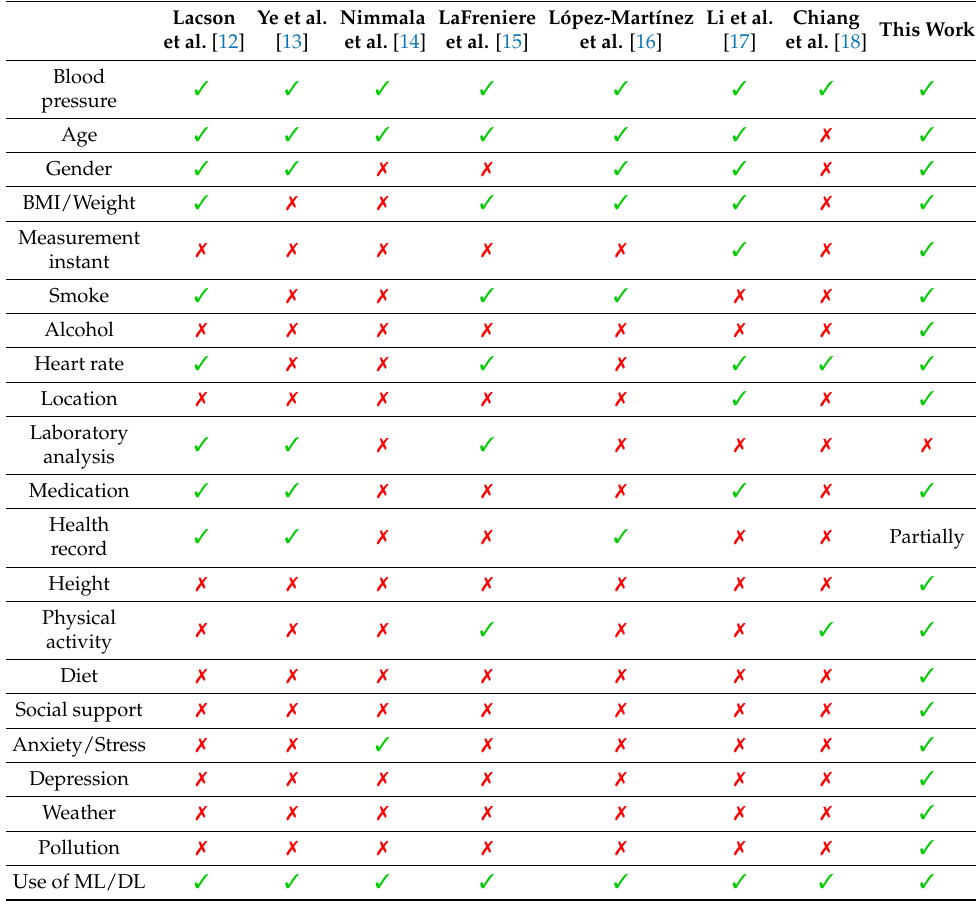
Table 1. List of features considered in the publications analyzed in the literature. A green tick ( (cid:51) ) indicates that a publication has considered a particular feature, while a red mark ( (cid:55) ) highlights that the work did not consider